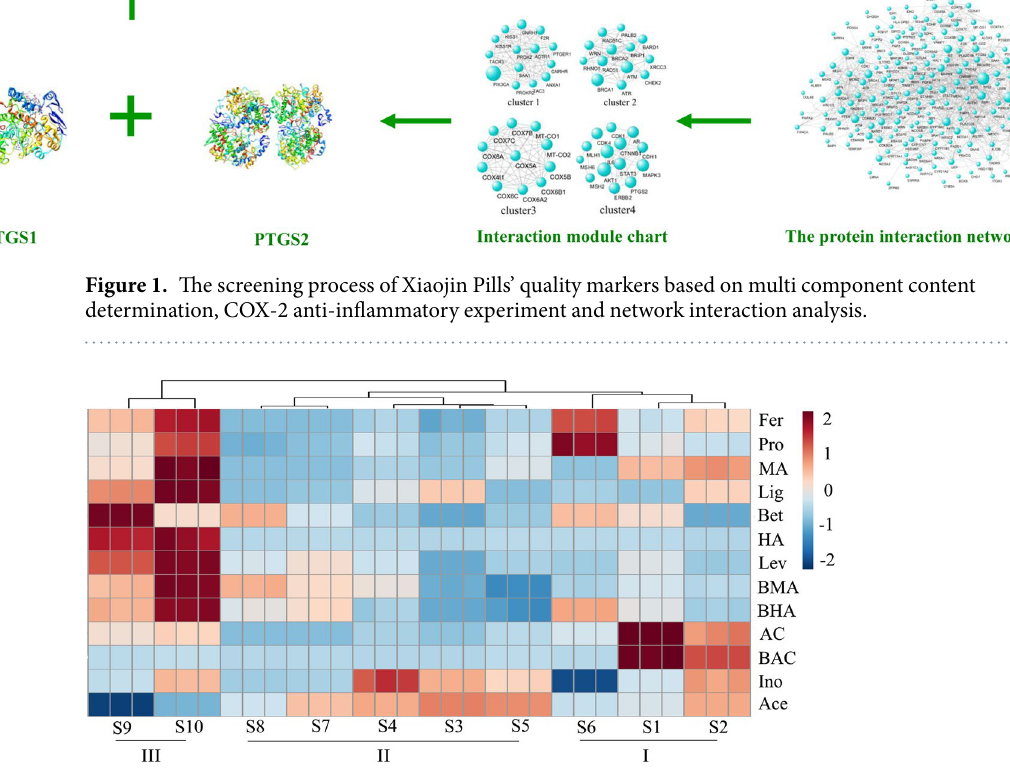
Figure 2. CA result of different batches of Xiaojin Pills based on chemical